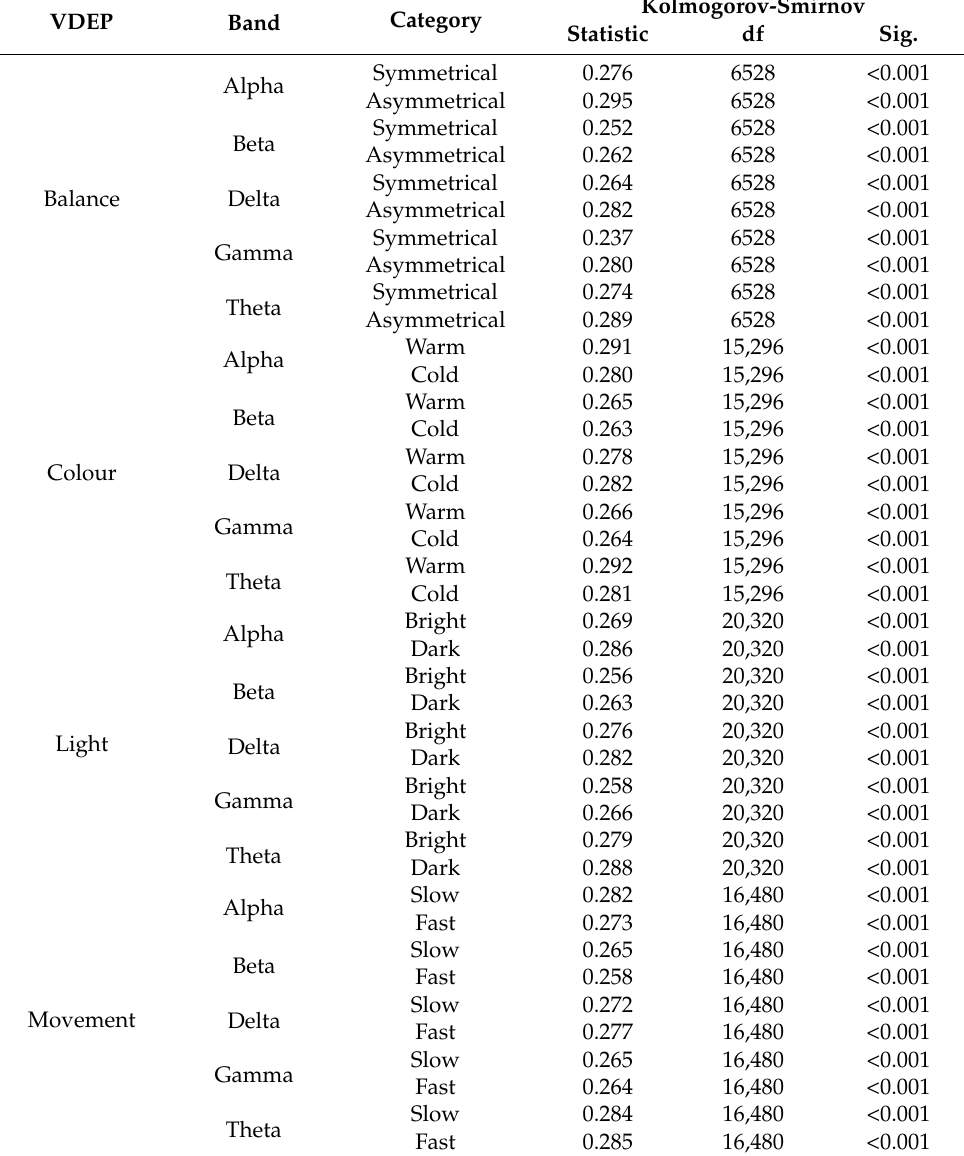
Table A1. Test of normality of the measurements of the mean Alpha, Beta, Delta, Gamma, and Theta bands, measured in the EEG records related to the Balance, Colour, Light, and Movement